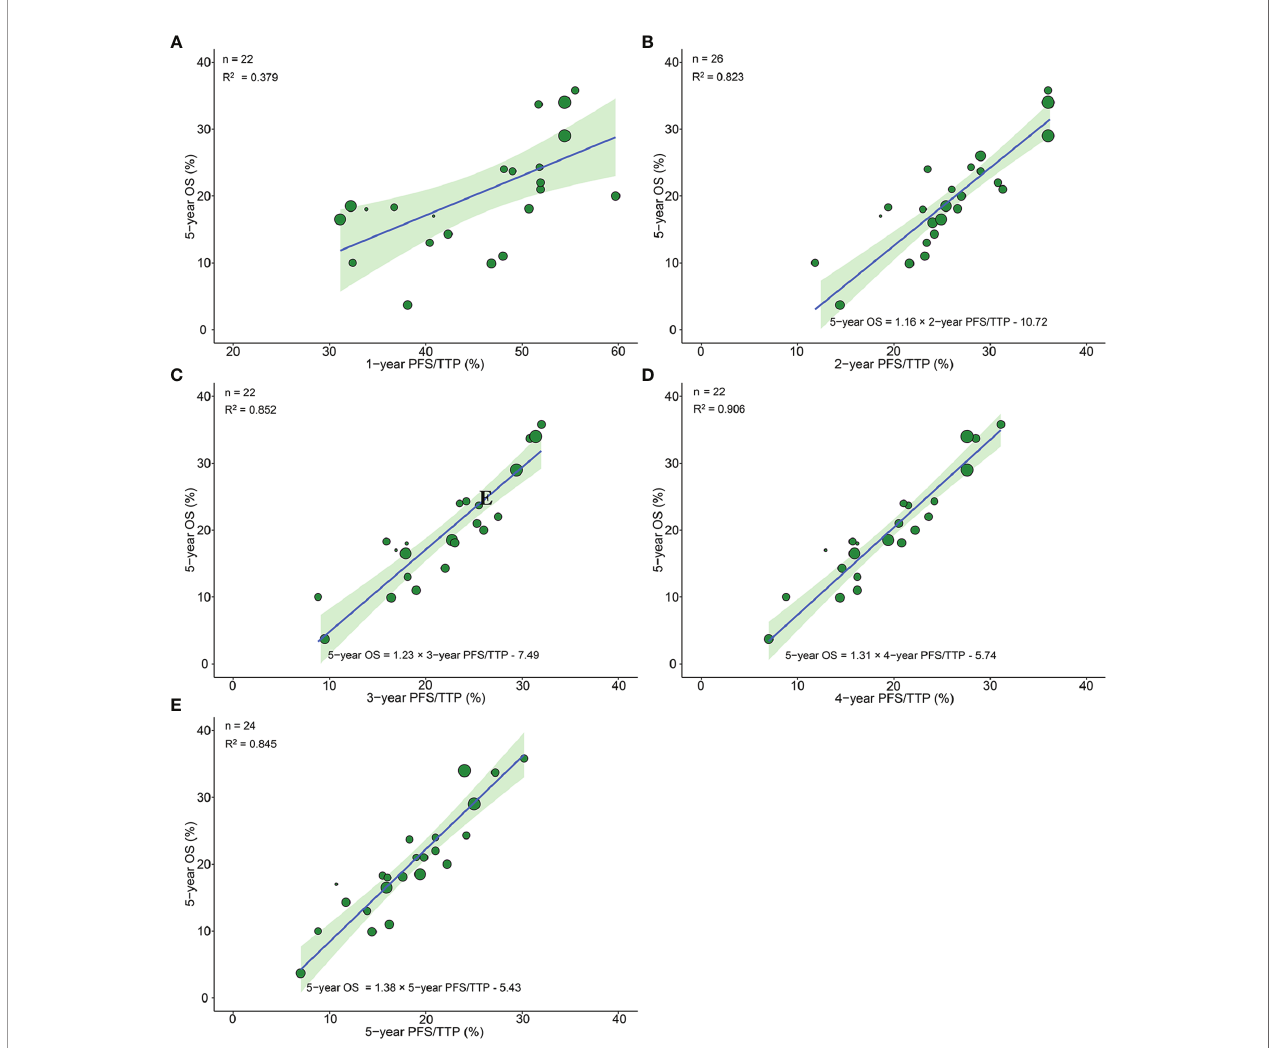
FIGURE 3 | Treatment arm-level correlation between 5-year OS and 1-year PFS/TTP (A) , 2-year PFS/TTP (B) , 3-year PFS/TTP (C) , 4-year PFS/TTP (D) , 5-year PFS/TTP (E) in phase III RCTs. Green circles represent treatment arms with a size proportional to the number of patients, blue lines for the estimated regression lines and the light green zones for 95% con fi dence intervals. OS, overall survival; PFS/TTP, progression free survival/time to progression; RCTs, randomized controlled